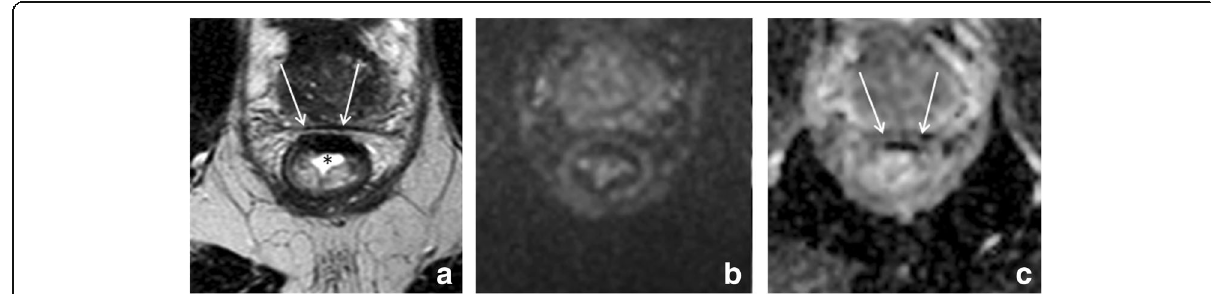
Fig. 8 Pitfall of low ADC in fibrosis. Example of the post-CRT T2-weighted MRI ( a ), b1000 diffusion-weighted MRI ( b ), and ADC map ( c ) of a male patient treated for a low rectal tumor. The patient was a complete responder. A fibrotic wall thickening is present in the anterior rectal wall (arrows). On the ADC map ( c ), a markedly low signal is observed in the fibrosis, which is due to the high collagen content in fibrosis (that has a short T2 relaxation time) and should not be mistaken for restricted diffusion due to tumor. On DWI ( b ), the signal in the rectal wall is homogeneously low, indicating that there is no restricted diffusion. Note again the star-shaped shine-through of high T2 signal (*) caused by some fluid in the rectal